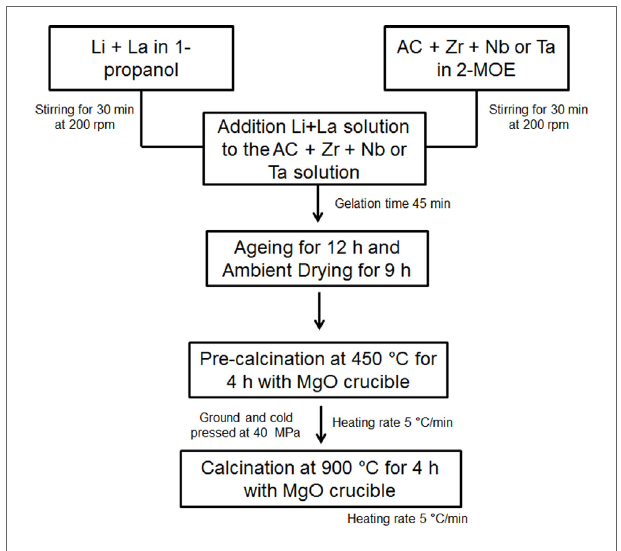
FigUre 1 | Process flow chart of sol–gel synthesis for